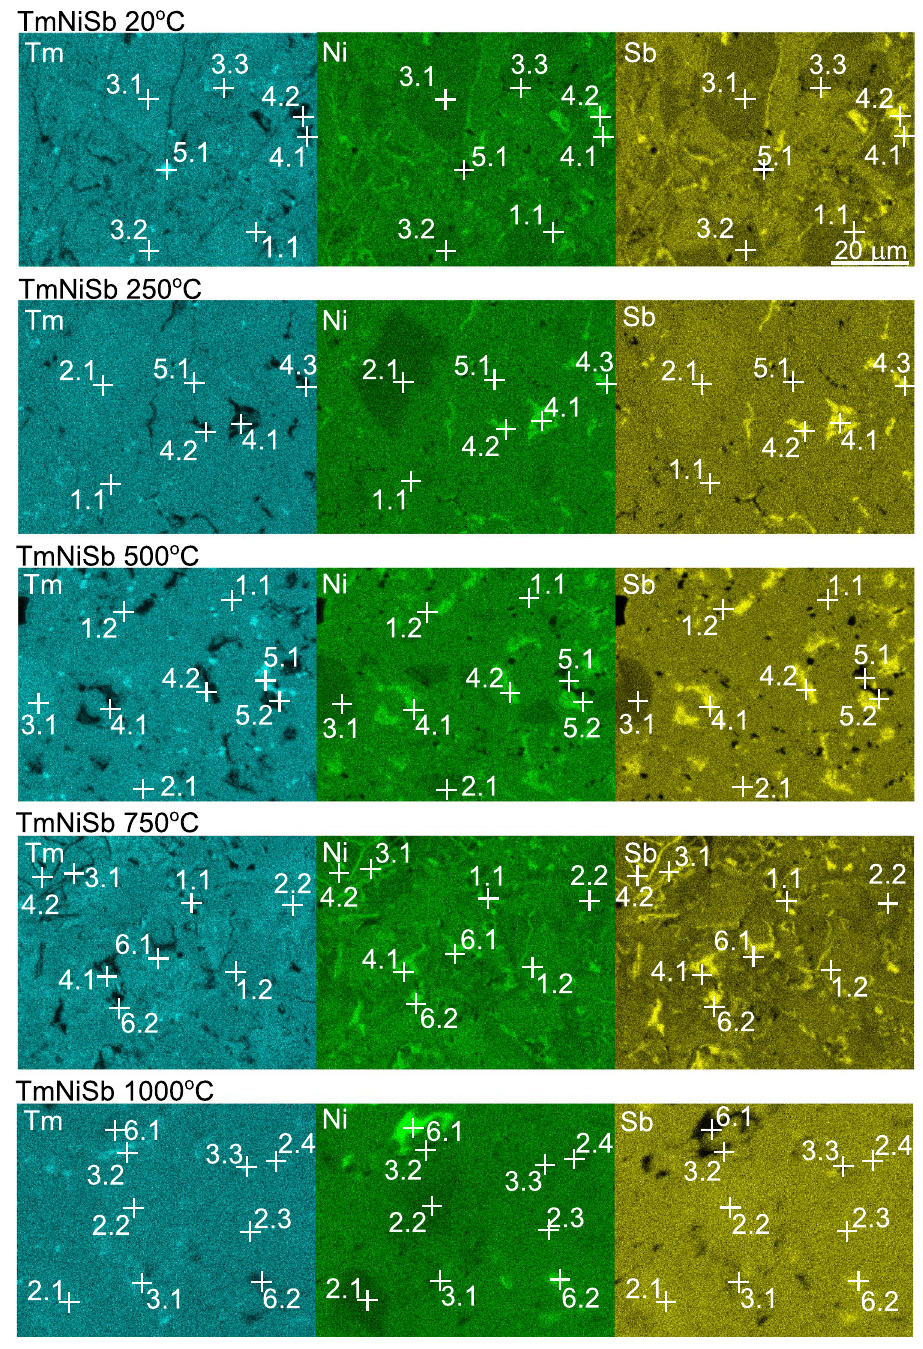
◦ C. For results of